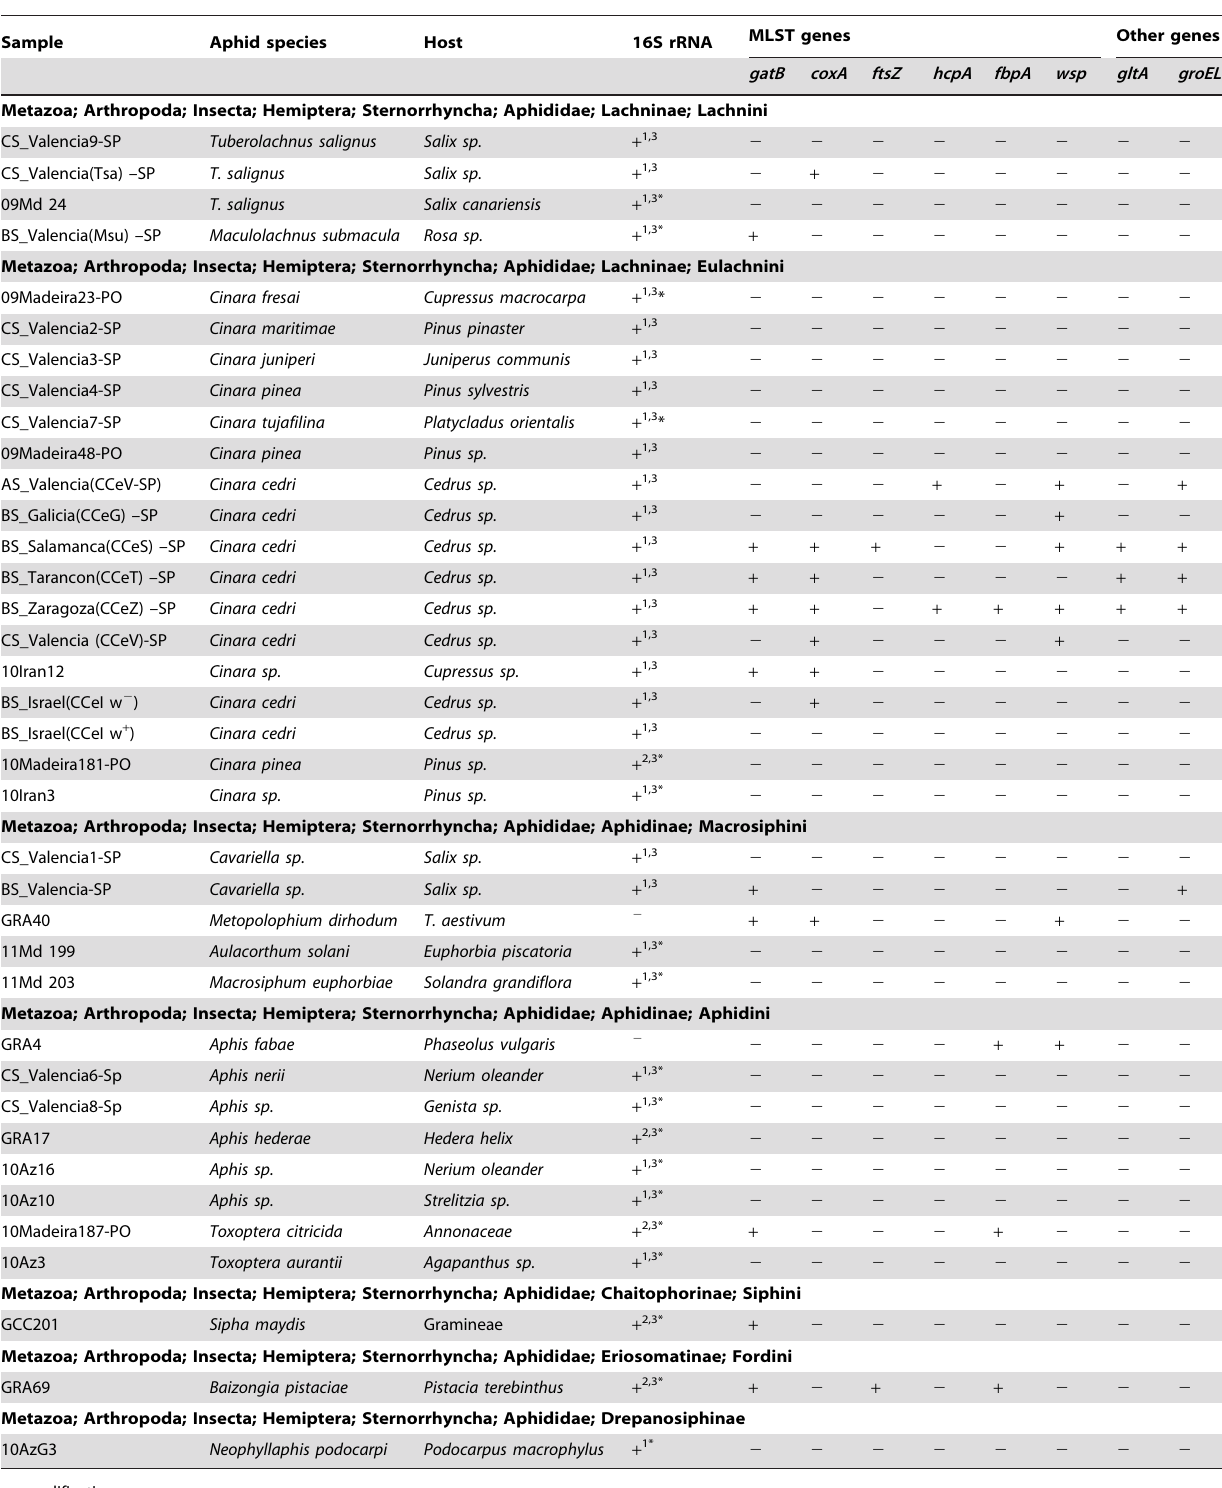
Table 1. Aphid populations positive for Wolbachia and PCR amplification results for 16S rDNA, MLST, wsp , gltA and groEL genes.